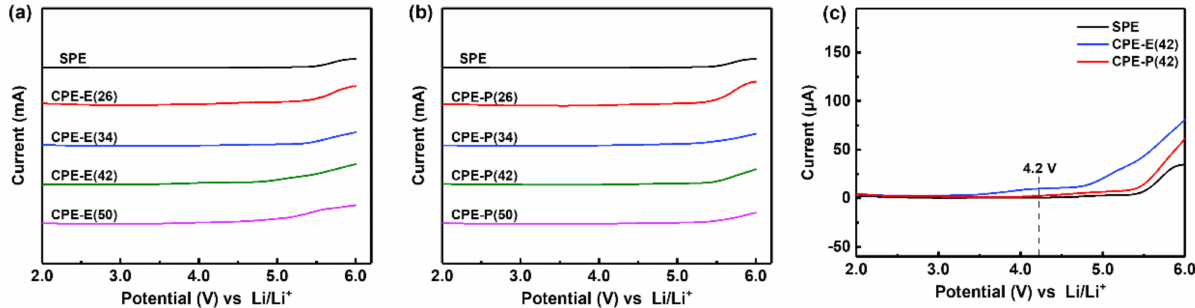
Figure 4. LSV curves of CPE-E( ω ) ( a ) and CPE-P( ω ) ( b ) at 25 ◦ C, respectively. ( c ) Enlarged LSV curves for SPE, CPE-E(42) and